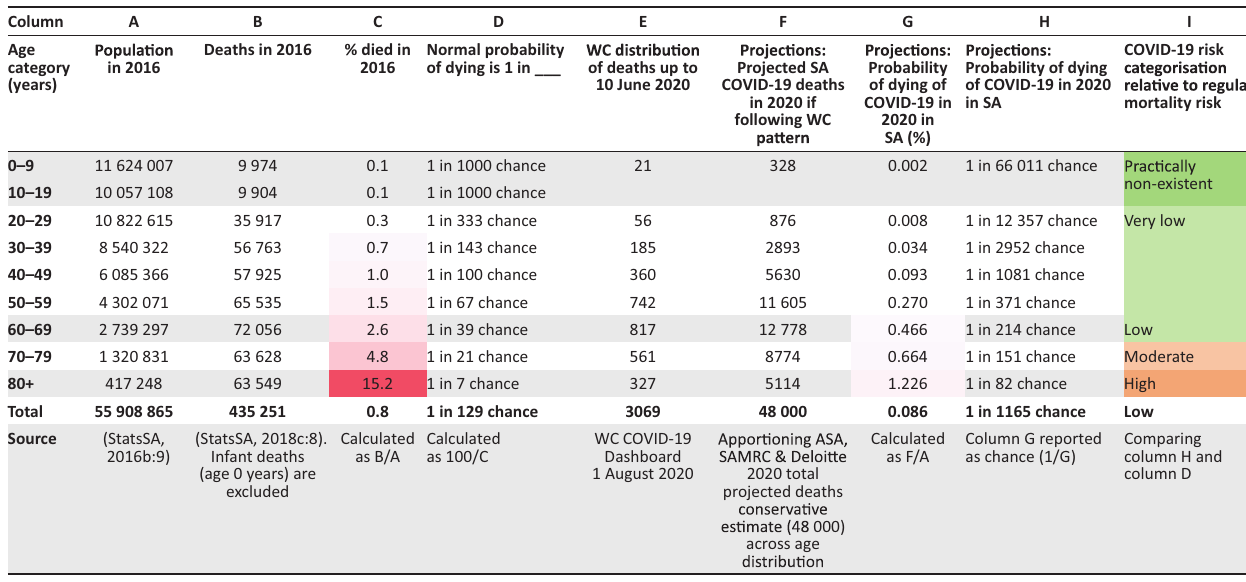
FIGURE 2: Comparing risk of death in a regular year and risk of death from COVID-19 infection by